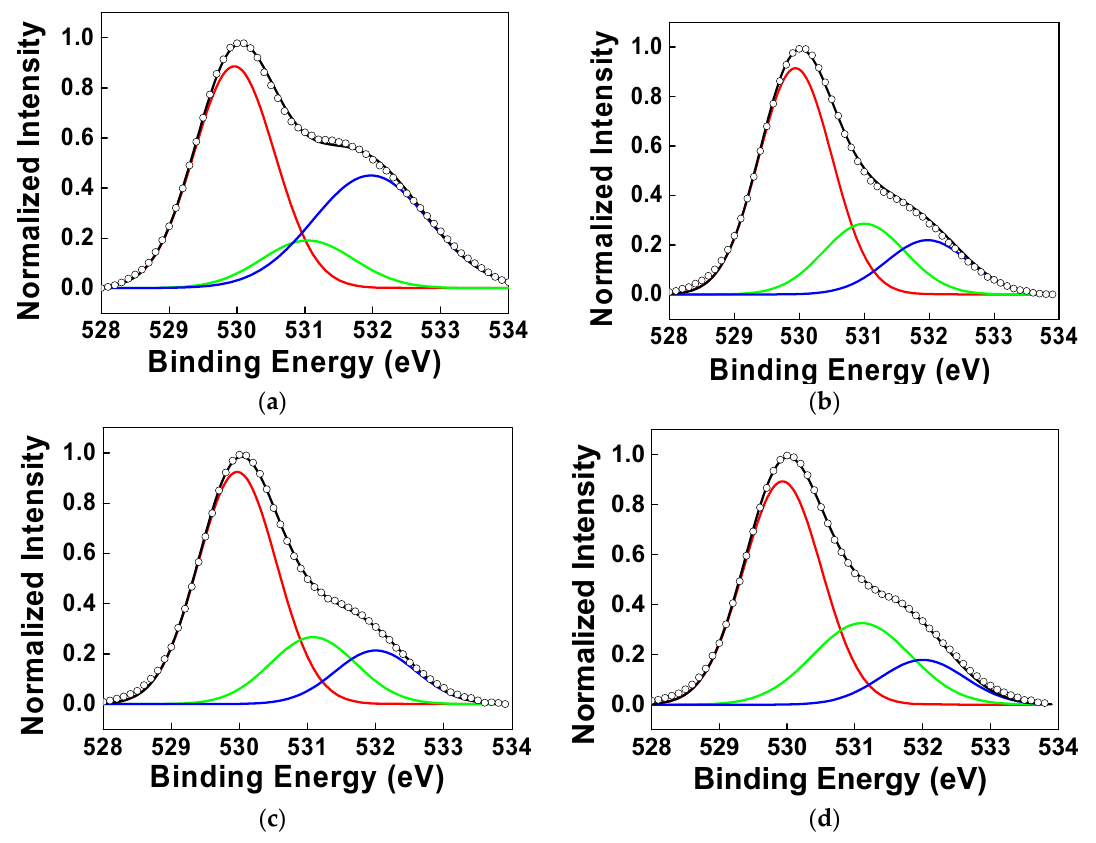
Figure 3. The X-ray photoelectron spectroscopy (XPS) spectra (black lines with open circle symbols) of ( a ) hot plate (H/P) at 50 °C for 2 min, ( b ) H/P at 300 °C for 10 min, ( c ) H/P + IPL (3 kV, 10 shots) and ( d ) H/P + IPL (3 kV, 15 shots). The data shows the peak position of O1s. Deconvolution of the XPS spectra shows the contributions of peaks at 529.9 (red), 531.0 (green) and 531.9 eV (blue) from oxygen atoms, respectively, in M–O–M lattice, near oxygen vacancies and in M–OH compounds.